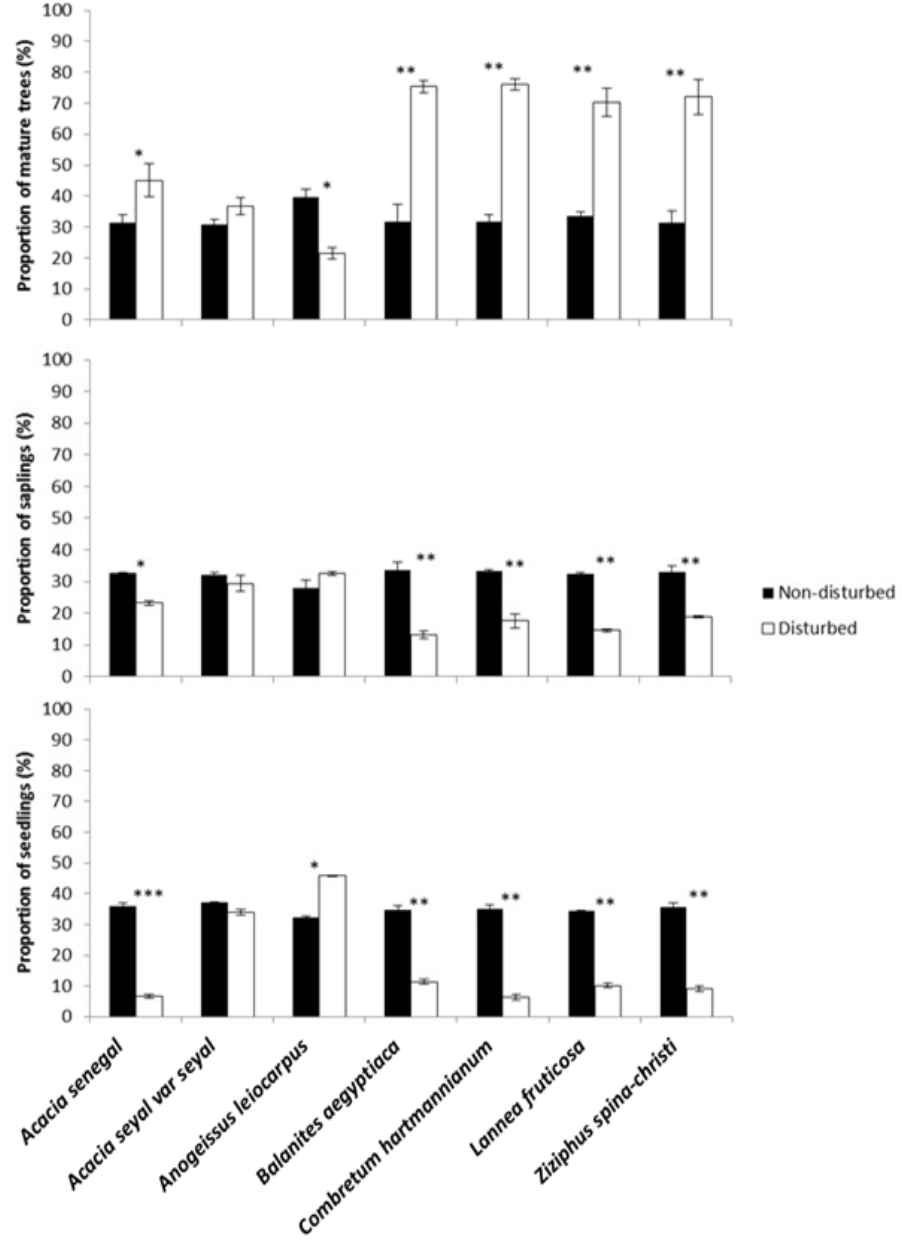
Figure 2. The proportions of mature trees, saplings and seedlings (%) of the seven most common tree species in the non-disturbed and disturbed sites of the Dinder Biosphere Reserve in the year of 2020. Asterisks above the bars show significant differences across the sites for each species according to Tukey’s Post-Hoc tests (* = p < 0.05; ** = p < 0.01; *** = p < 0.001; n = 406).